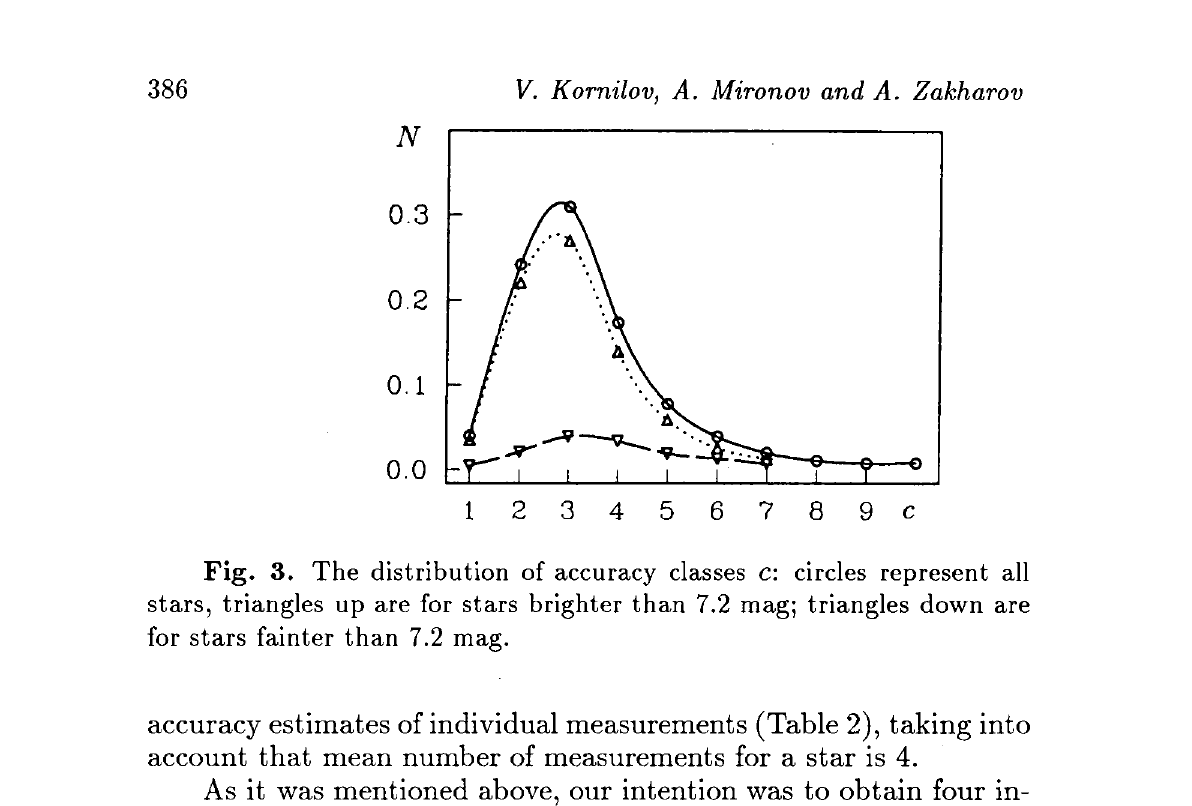
Fig. 3. The distribution of accuracy classes c: circles represent all stars, triangles up are for stars brighter than 7.2 mag; triangles down are for stars fainter than 7.2